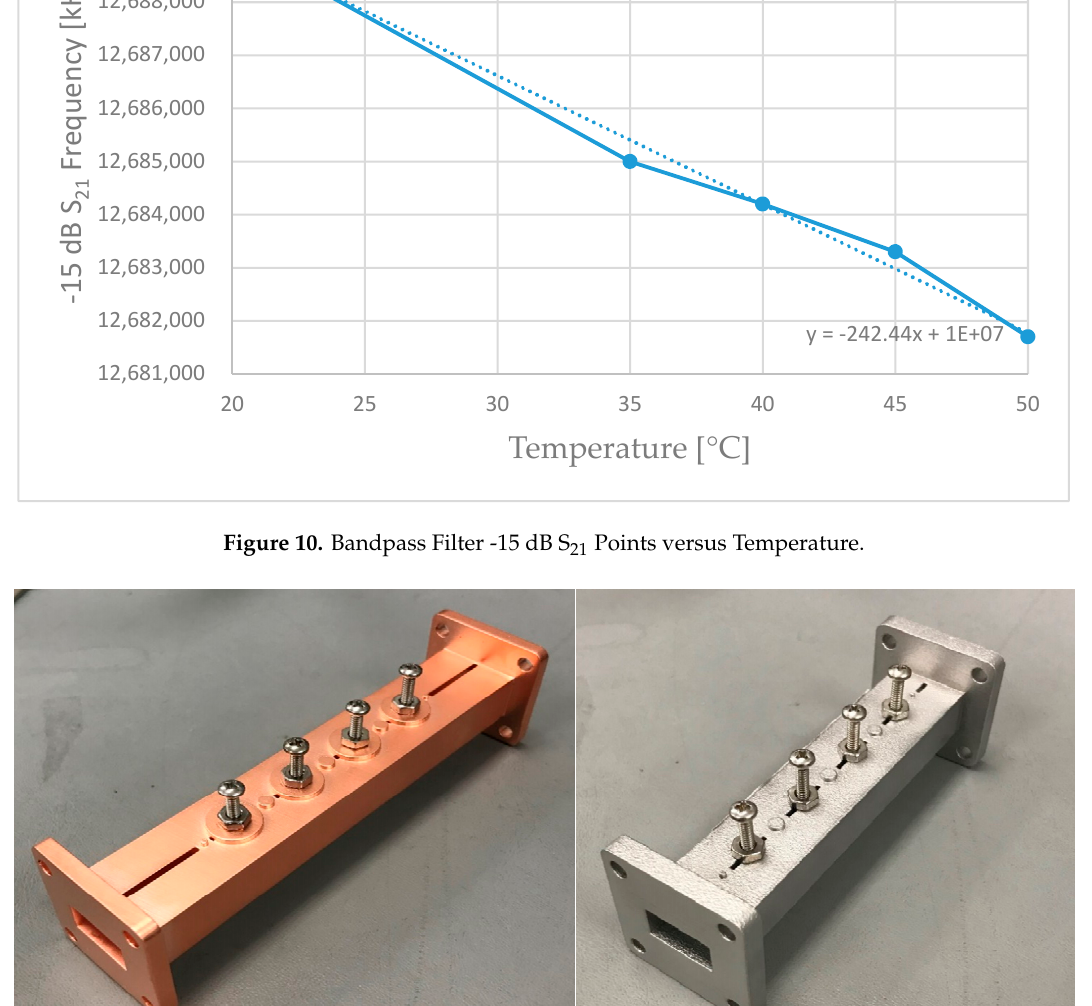
Figure 12. Bandpass filter scaling in HFSS Δ T = 0–50 °C. 3. Conclusions Resins used for stereolithography 3D printing typically have high CTE. Microwave structures manufactured with 3D printing using SLA and copper plated can have strong frequency dependence on temperature. In particular, multi-cavity filters with narrow bandwidth are strongly affected by dependence of resonant frequency on temperature. This can preclude their usefulness if the frequency drift approaches the bandwidth of the device. Electroplating with layers of copper and nickel to strengthen the metal coating resists the expansion of plastic and reduces temperature dependence. Using DMLS metal printing approaches metal structure performance, so that metal 3D printed structures can approach temperature characteristics of solid metal structures. Single cavity notch filters printed with lower CTE resin can be useful if a wide enough notch bandwidth is used to accommodate frequency drift. One must choose the right 3D printing materials and processes to achieve the temperature stability required by the application. Funding: This research received no external funding . Conflicts of Interest : Page: 10 The authors declare no conflict of interest. References